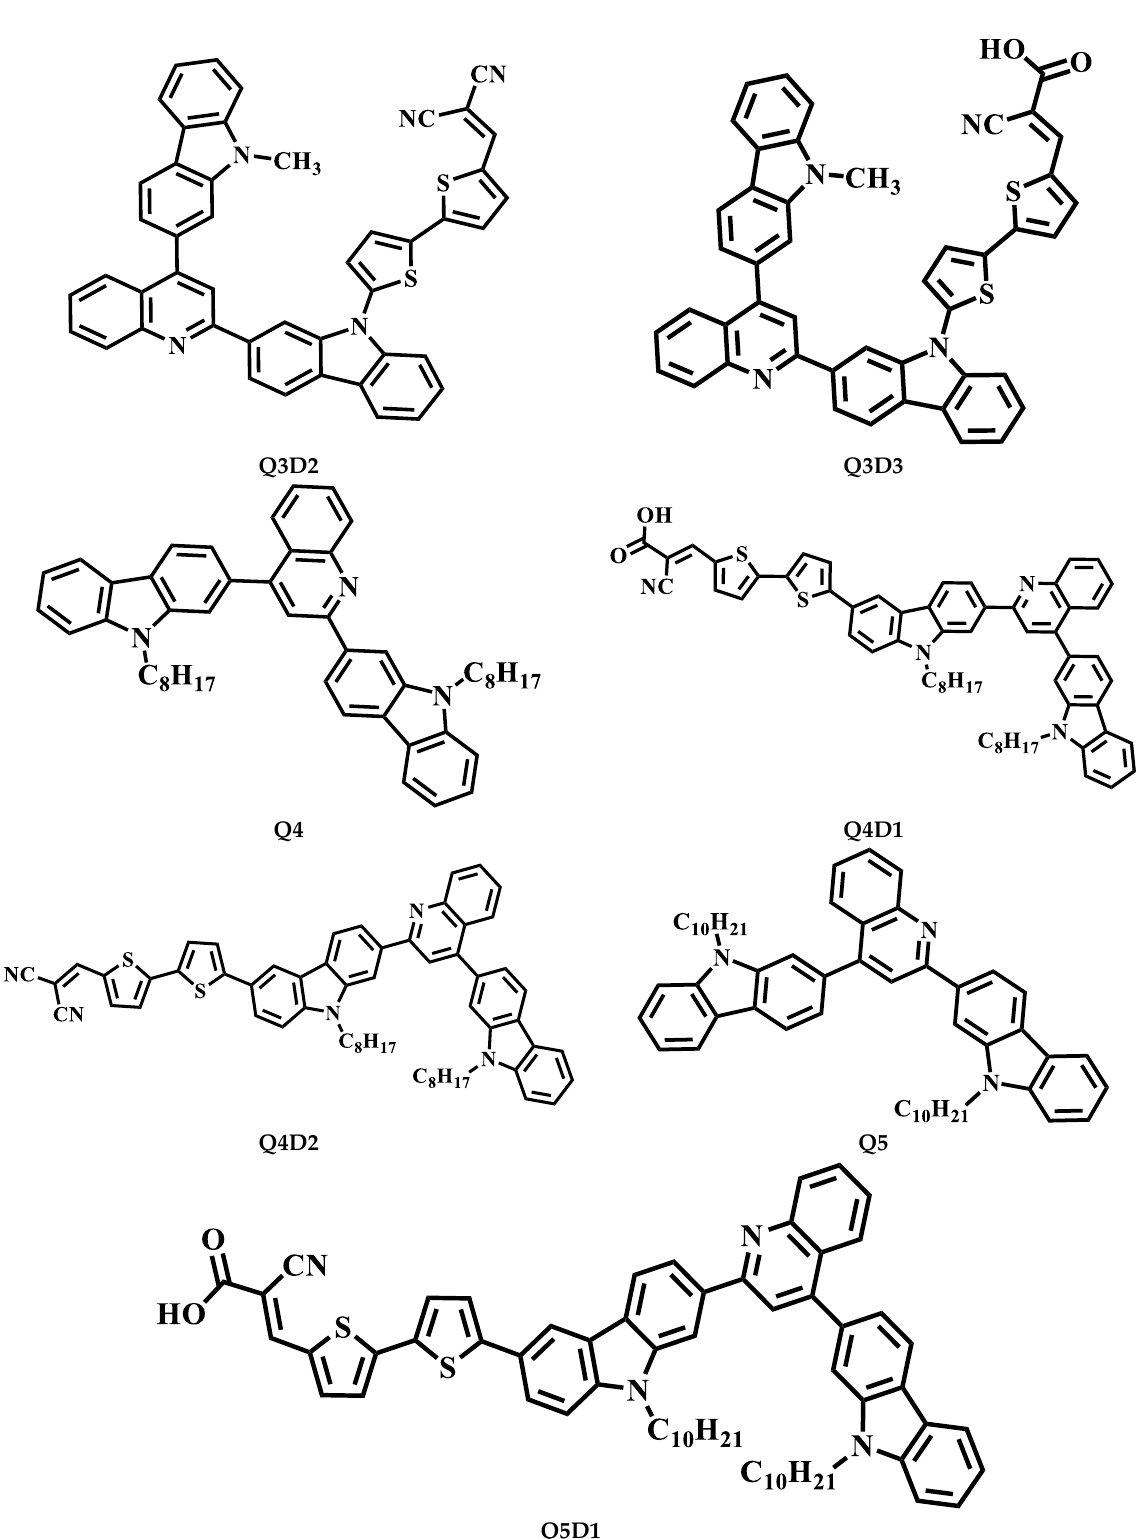
Figure 2 . Structures of studied compounds Q3D1 – Q3D3, Q4D1 – Q4D2 , and Q5D1 . Figure 2. Structures of studied compounds Q3D1 – Q3D3, Q4D1 – Q4D2 , and Q5D1